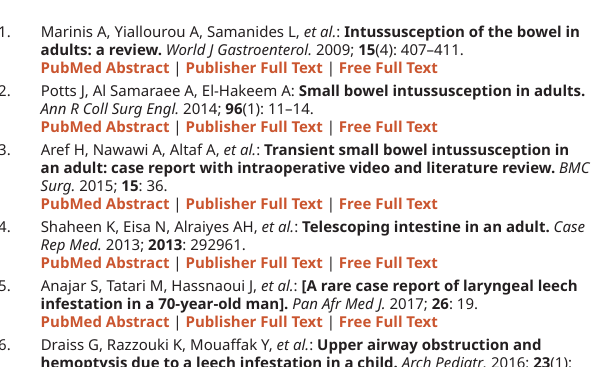
resected, and anastomosis was done in two layers. A biopsy of the leading tumor later showed it to be a simple hemangioma of the small intestine. In her postoperative management, she was kept NPO for 3 days and took intravenous fluids. Ceftriaxone and metronidazole were continued for 10 days. On her second day postoperatively, abdominal auscultation revealed the start of bowel sounds. She was discharged 2 weeks after surgery and was appointed to come for her follow-up after a month. In her follow up visit full remission was